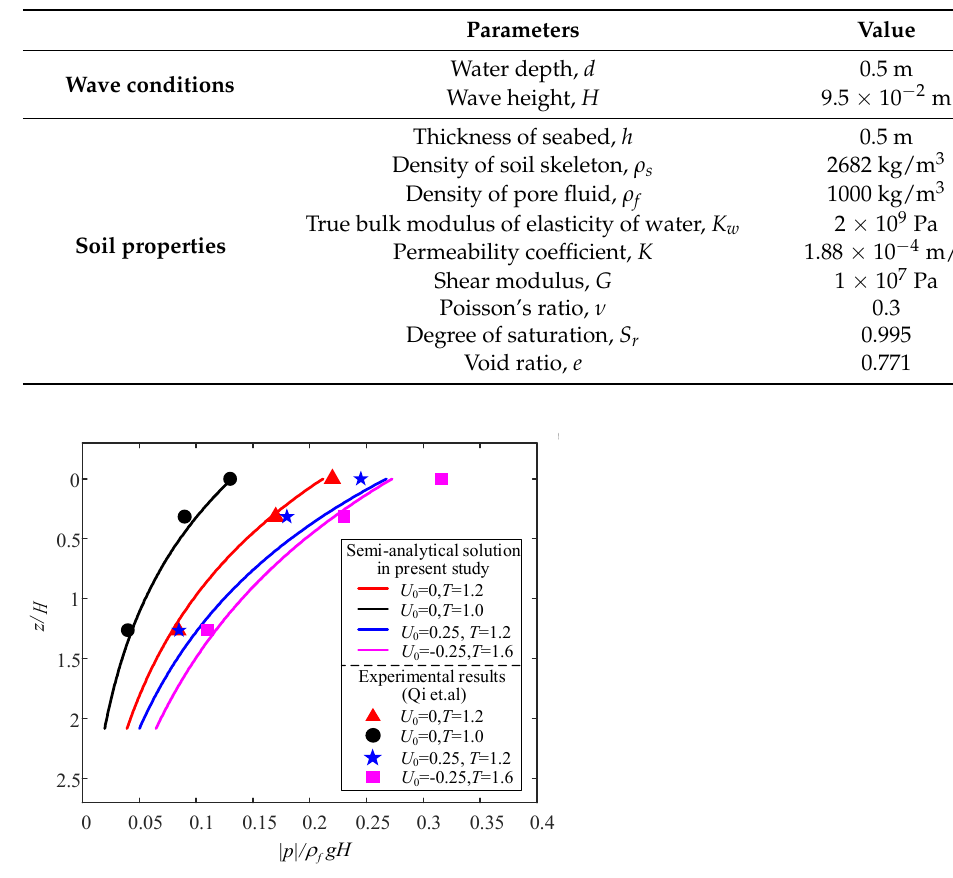
Table 2. Wave conditions and isotropic soil properties [48].